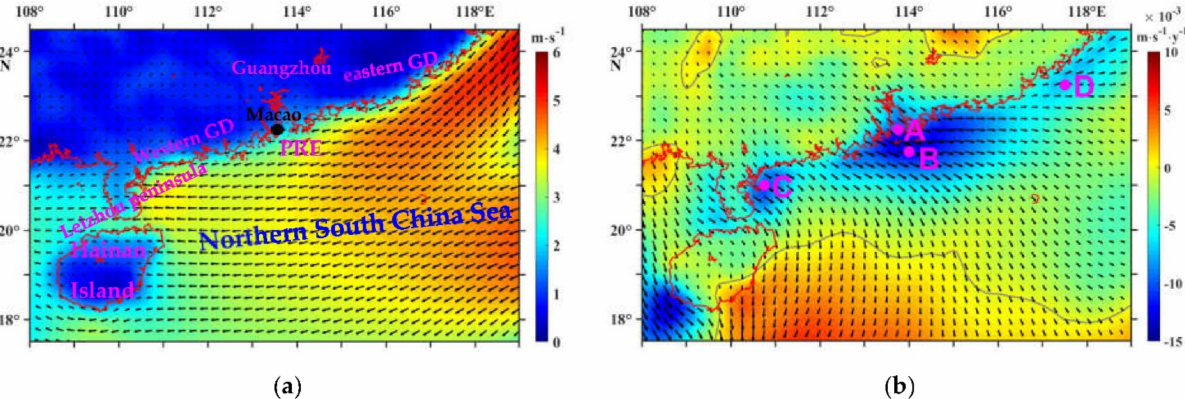
Figure 2. Spatial distribution of the annual mean wind field and its trend in the northern South China Sea from 1979 to 2019. ( a ) Annual mean wind field (contours indicate the wind speed); ( b ) Trend of the annual mean wind speed (shaded colors; grey contours represent 0, and negative values represent a decreasing trend) and trend of the wind vectors, which were obtained by calculating the trend of the zonal wind component ( u ) and the meridional wind component ( v ), respectively (represented by vectors). PRE: Pearl River Estuary. GD: Guangdong Province. Four representative stations, namely A (22.25 ◦ N, 113.75 ◦ E), B (21.75 ◦ N, 114.00 ◦ E), C (21.00 ◦ N, 110.75 ◦ E) and D (23.00 ◦ N, 117.50 ◦ E) in ( b ) are used for later